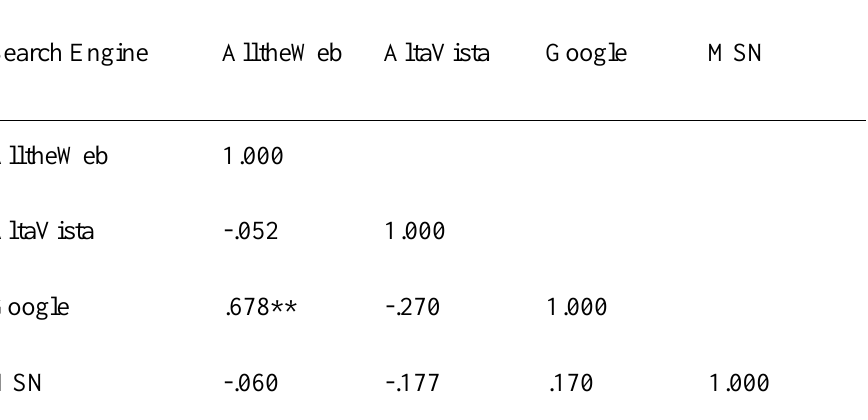
Correlation Matrix among Search Engine In-Link Counts (N = 46)